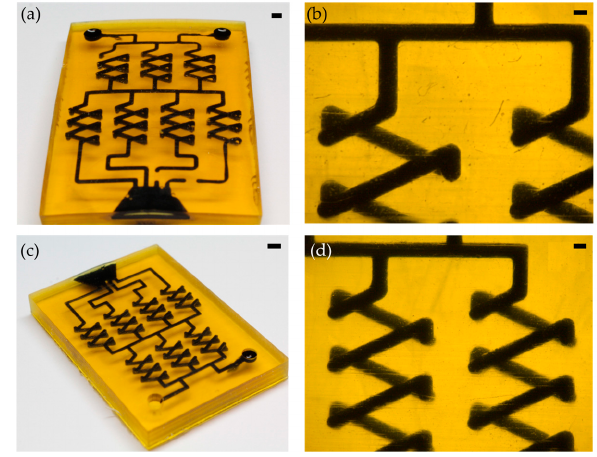
Figure 3. 3D printed perfluoropolyether (PFPE) microfluidic chips: ( a ) Front view of a gradient generator with a channel width and height of 800 µm, filled with black printing ink (scale bar: 2 mm); ( b ) Photomicrograph of the 800 µm gradient generator (scale bar: 500 µm); ( c ) Isometric view of the 600 µm gradient generator, filled with black printing ink (scale bar: 2 mm); and, ( d ) Photomicrograph of the 600 µm gradient generator (scale bar: 500 µm).